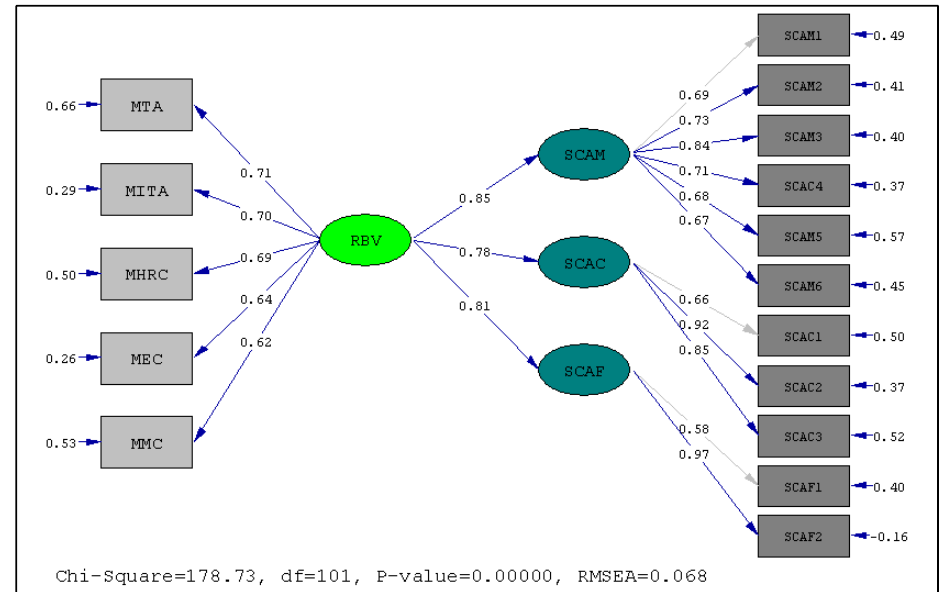
Fig. 3. Structural Relationship model between RBV and